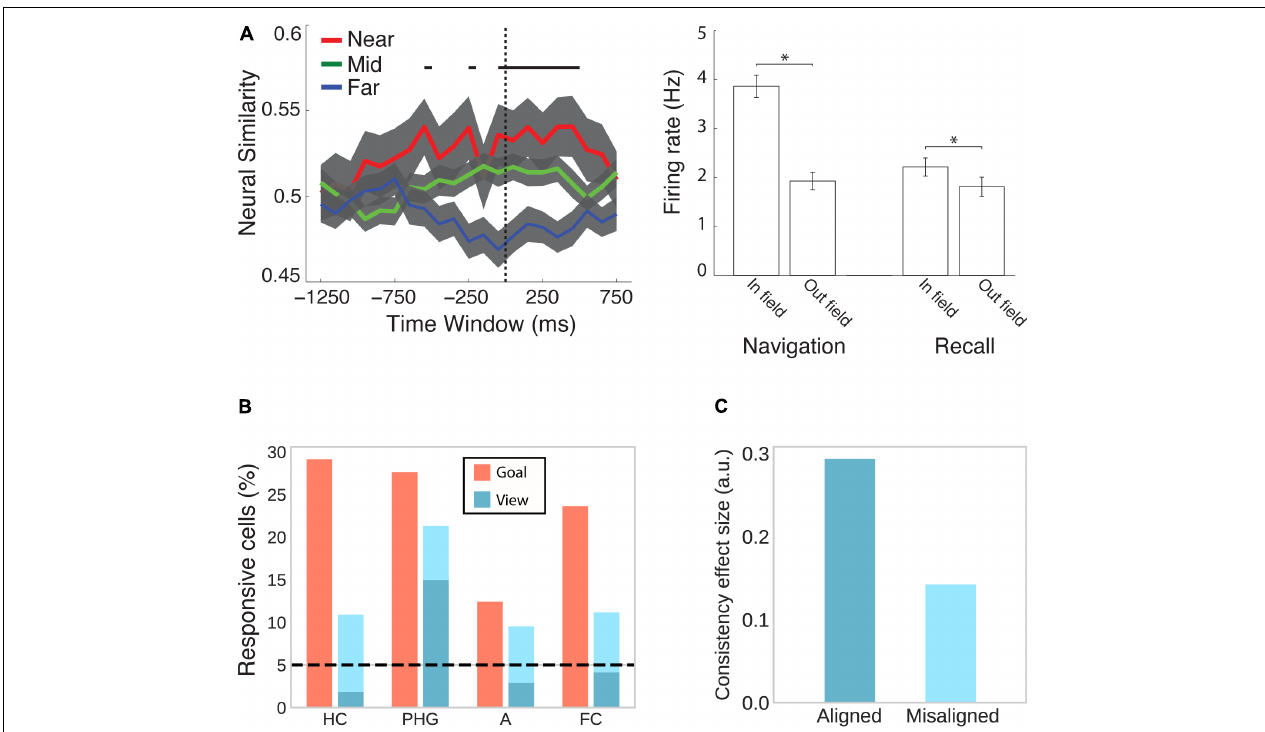
FIGURE 5 | Cells in the human MTL code non-spatial features as well as spatial features outside their respective spatial context. (A) While viewing a black screen, the activity of place cells is reinstated when subjects recall words that were encoded inside the cells’ place field in a virtual city environment. This effect is evident at the population ( left ) and individual cell ( right ) level. Adapted with permission (Miller et al., 2013) from Science. (B) Goal- and view- responsive cells in the hippocampus (HC), parahippocampal gyrus (PHG), amygdala (A), and frontal cortex (FC). Dark turquoise bars indicate responsiveness to stores and light turquoise bars indicate responsiveness to both stores and passengers. Adapted with permission (Ekstrom et al., 2003) from Springer Nature. (C) Evidence from fMRI suggests that cells in the entorhinal cortex show grid-like activity that codes position in a conceptual space representing visual features of birds (neck length and leg length). BOLD contrast was higher for viewing or imagining morphing trajectories that were aligned with the common grid orientation as compared with misaligned trajectories. Data from Constantinescu et al.